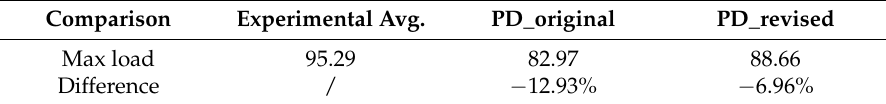
Table 4. Influence of the revised bond energy-based failure criteria on maximum